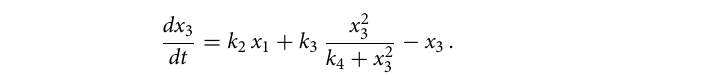
Figure 2. Adaptation alters the nonlinear mechanism of decision making. ( a ) Coarse grained model combining a negative feedback loop (NFL) between x 1 and x 2 species and self-activation positive feedback loop (PFL) of x 3 species. ( b ) Typical adaptation and switching dynamics in response to a stimulus step. Color code relates to that of panel ( a ) and model parameters are β = 1 and τ = 10 . ( c ) Effect of adaptation parameters β and τ on the linear response regime (upper panel) and the overshoot profile of the adaptation response of x 1 ( t ) (left and right bottom panel). ( d ) Plot of s sn − s c as a function of β and τ where two distinct transition regimes ( s c = s sn and s c < s sn ) are separated by the white boundary. ( e ) Single-cell trajectories plotted in the { x 1 , x 3 } space for increasing level of stimulus s (blue for s < s c and green for s > s c ): Upper panel (red square: β = 1 and τ = 10 ) shows a saddle collision for s = s c and bottom panel (grey circle: β = 0.3 ; τ = 3 ) shows a saddle-node bifurcation. Black full and gray dashed lines represent the steady state branches (cid:31) x st 1 ( s ) and (cid:31) x sad ( s )